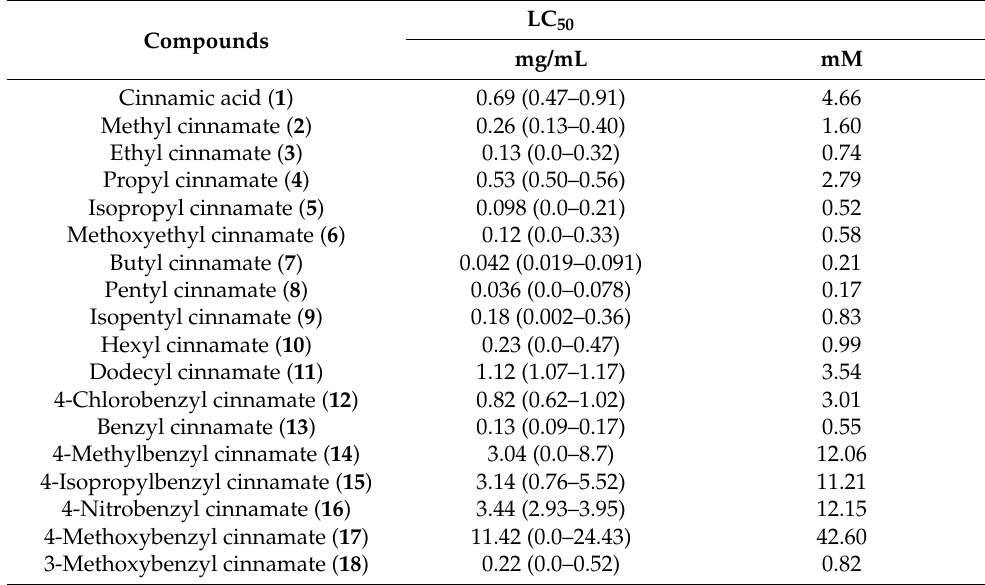
Table 1. Larvicidal activity of cinnamic acid and its derivatives against Ae. aegypti fourth instar larvae after 24 h of exposure.